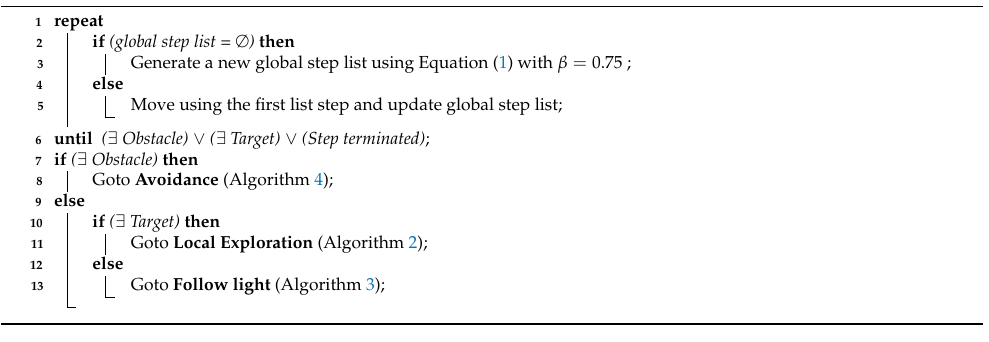
Algorithm 1: Global Exploration (exploration).